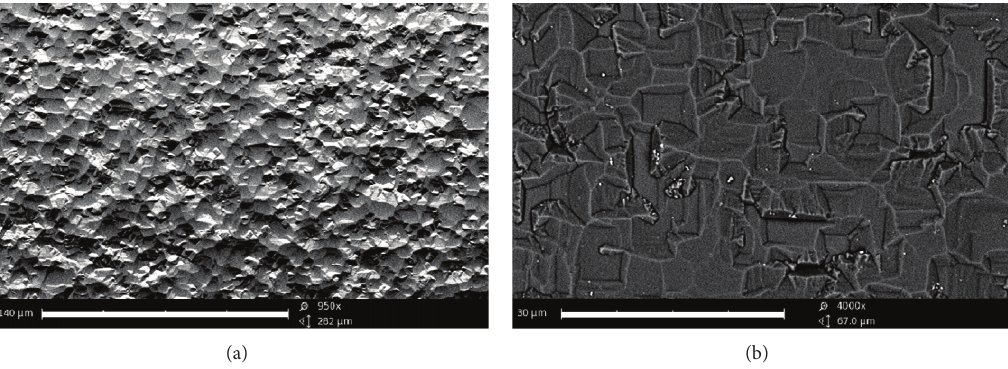
Figure 6: SEM images of an 87nm thick BiFeO 3 film prepared at a source-to-substrate distance of 6 󸀠󸀠